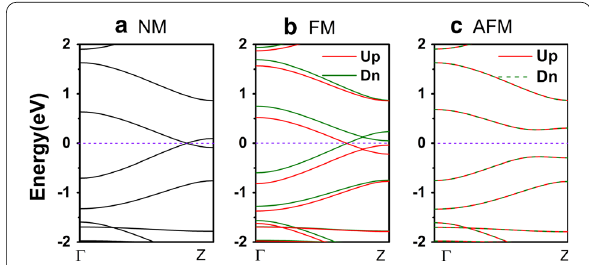
Fig. 2 (Color online) The band structures for the ZγGYNR are shown within the a NM, b FM, and c AFM states, respectively. The Fermi level has been taken as